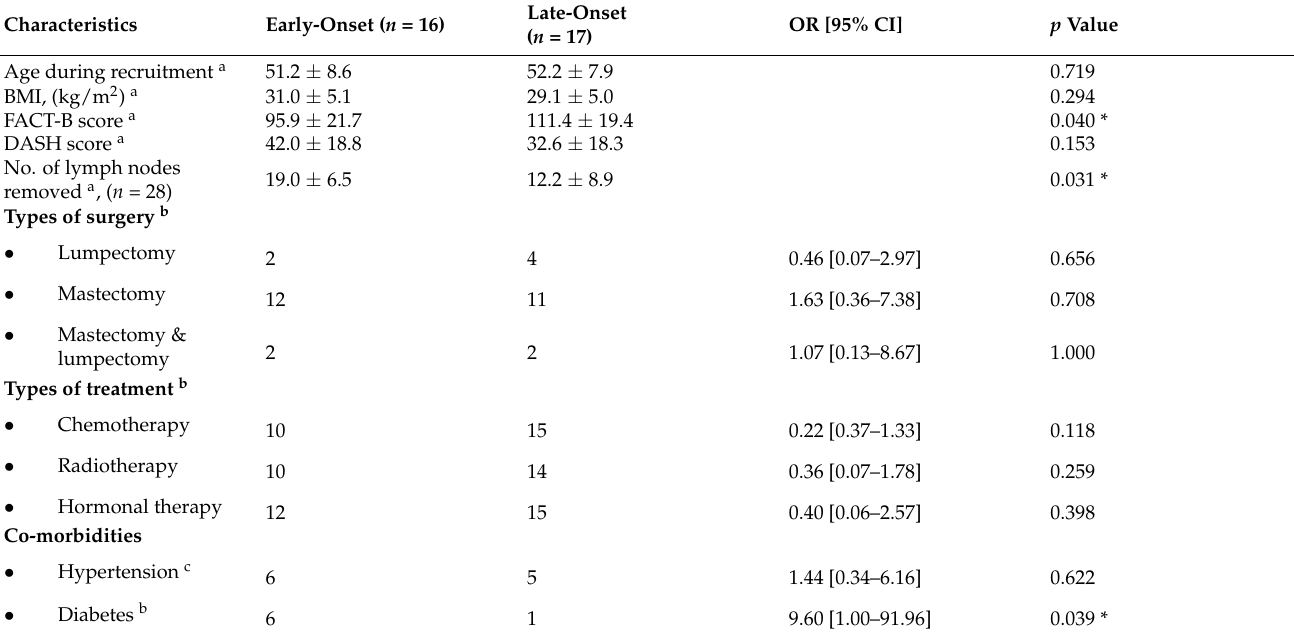
Table 5. Univariate analysis of factors associated with onset of BCRL.